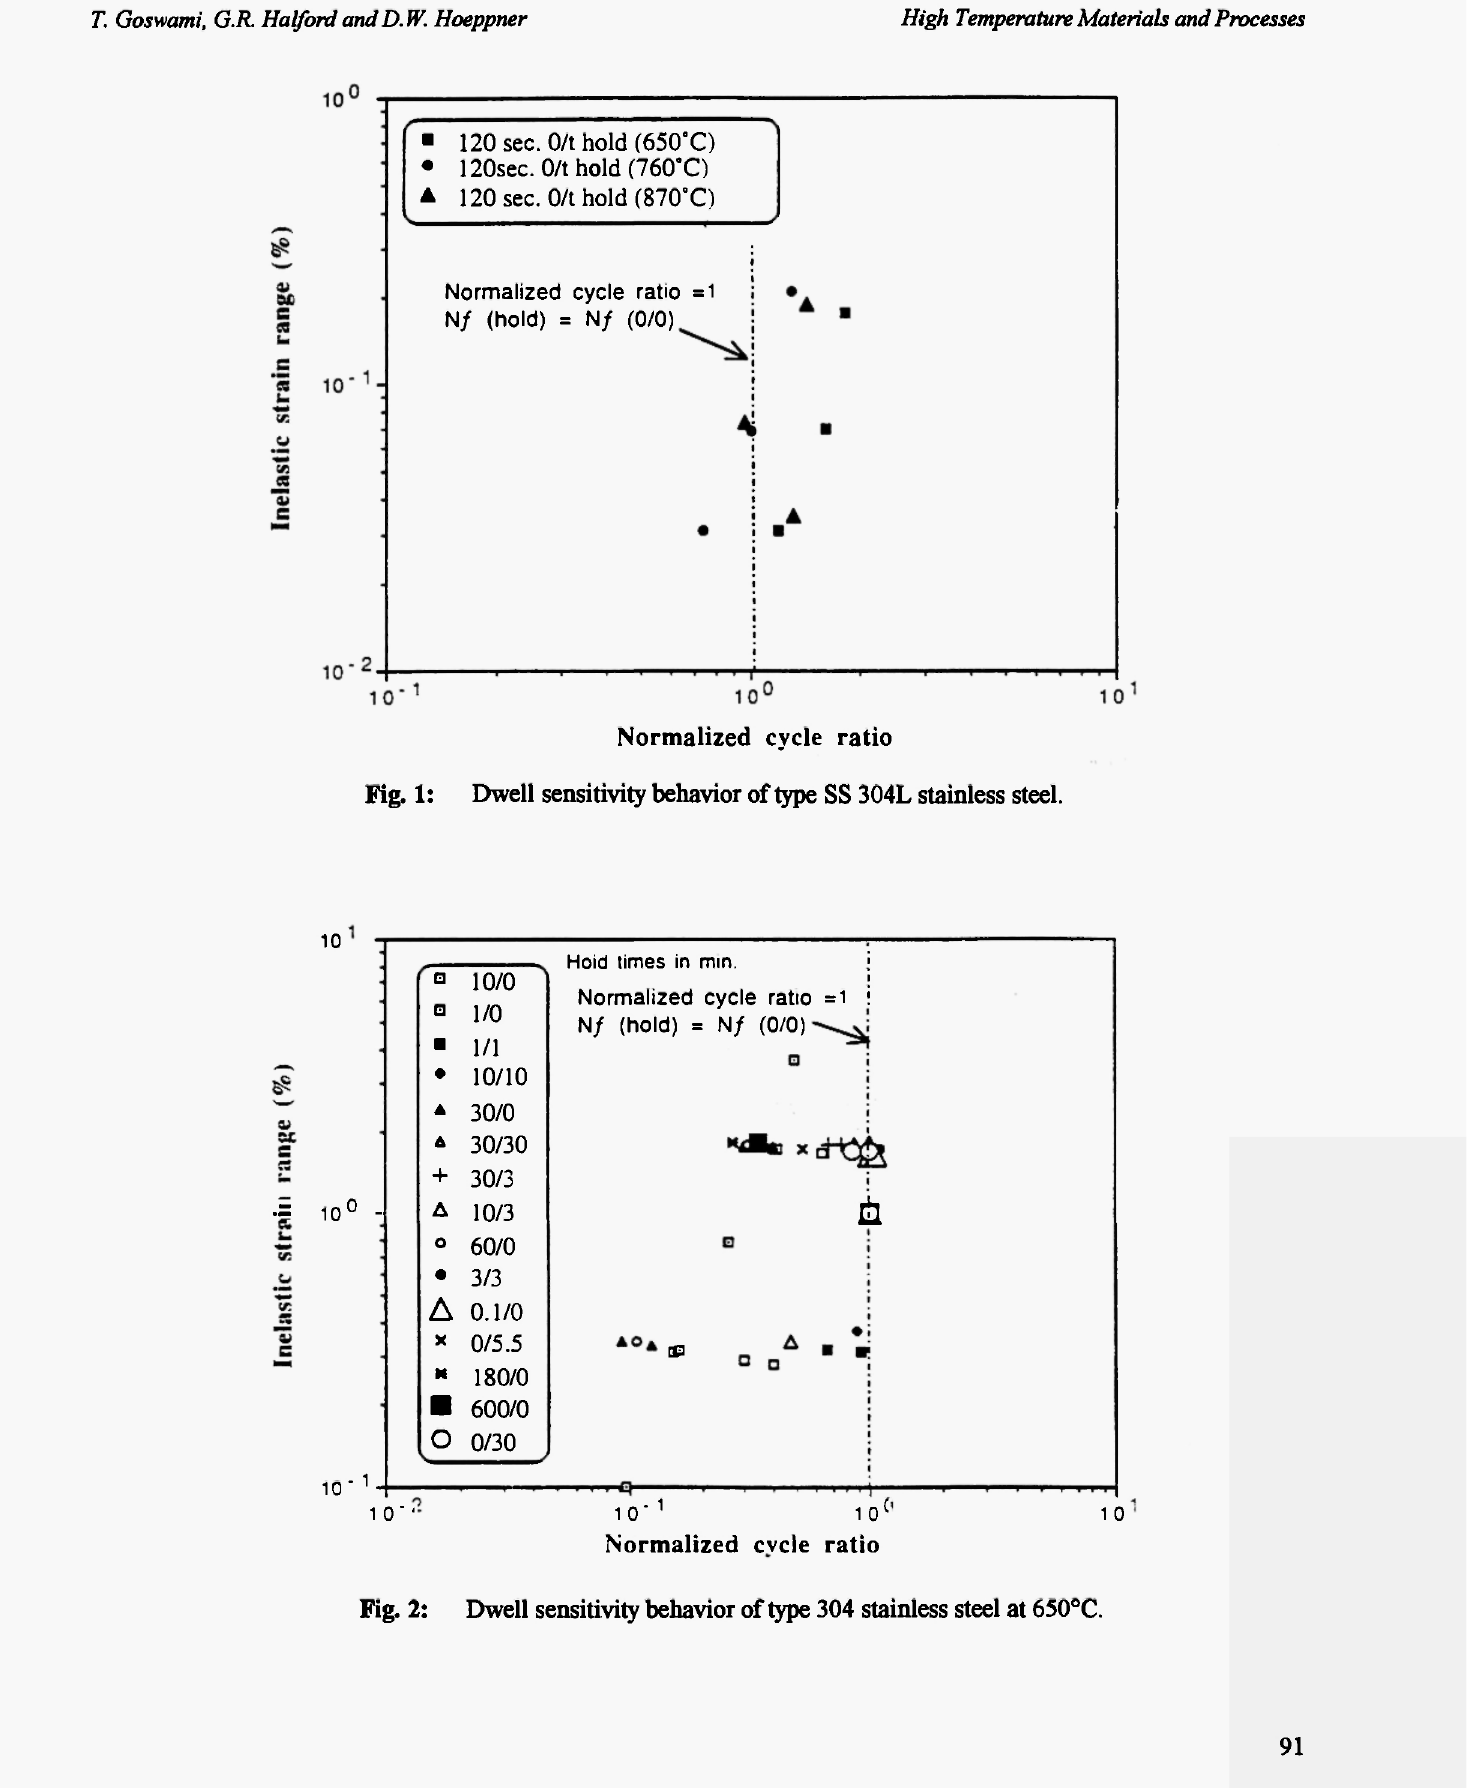
Fig. 2: Dwell sensitivity behavior of type 304 stainless steel at